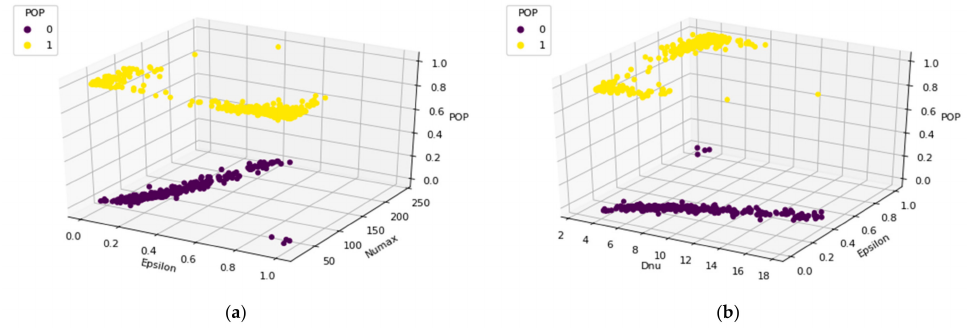
Figure 6. The 3-dimensional (3D) analysis of Epsilon, Numax and Dnu with the POP is conducted. The analysis is listed as: ( a ) the 3D analysis of Epsilon and Numax by target POP; ( b ) the 3D analysis of Epsilon and Dnu by target